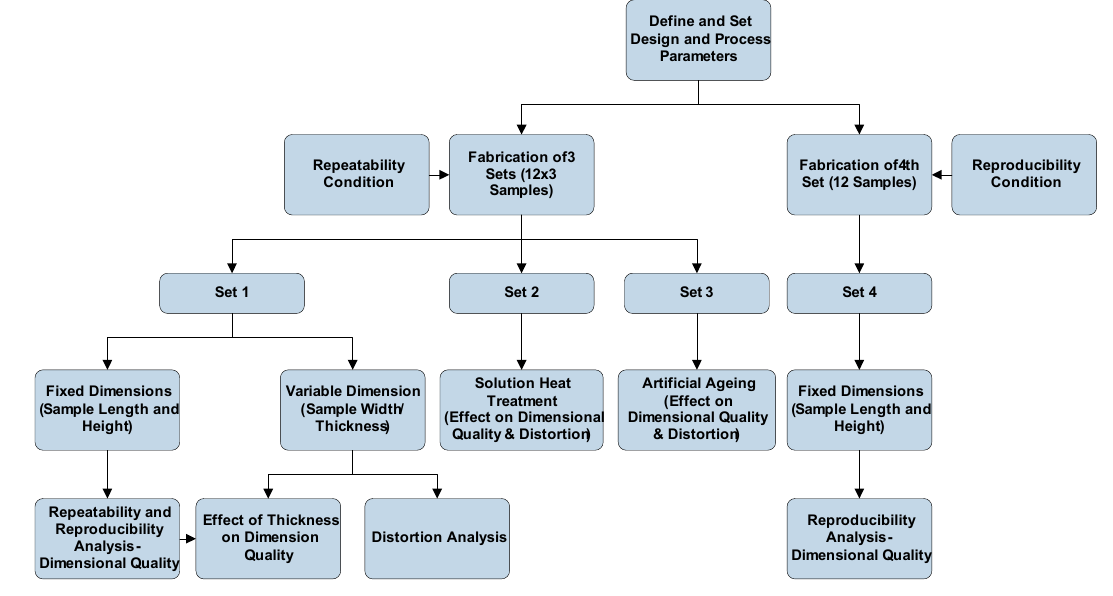
Figure 2. Experimental Scheme.